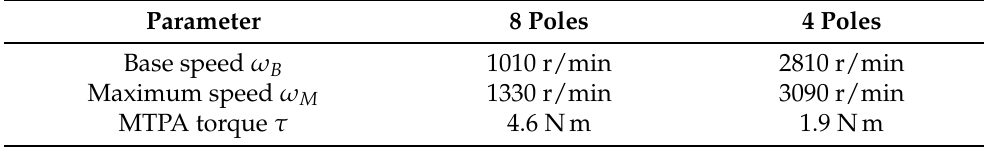
Table 4. Mechanical characteristics: data